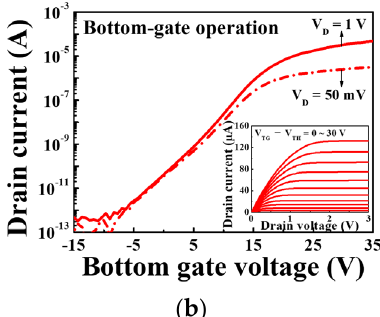
Figure 4. Schematic of the ( a ) SG mode and ( b ) DG mode sensing operations.